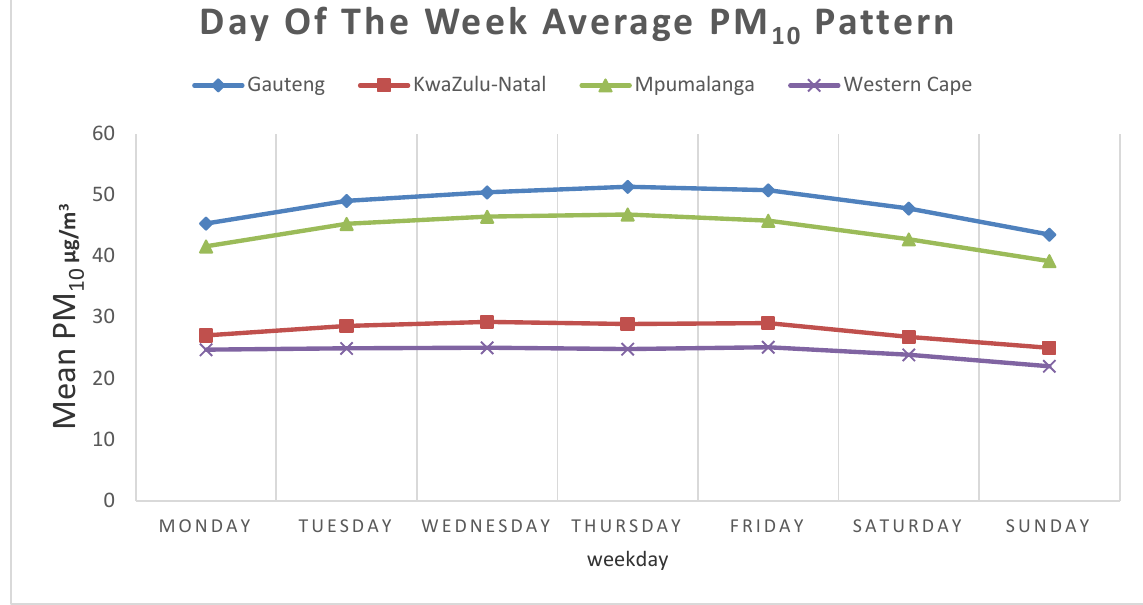
Figure 4. Weekdays variation in average daily PM 10 μ g/m 3 concentration across the provinces.